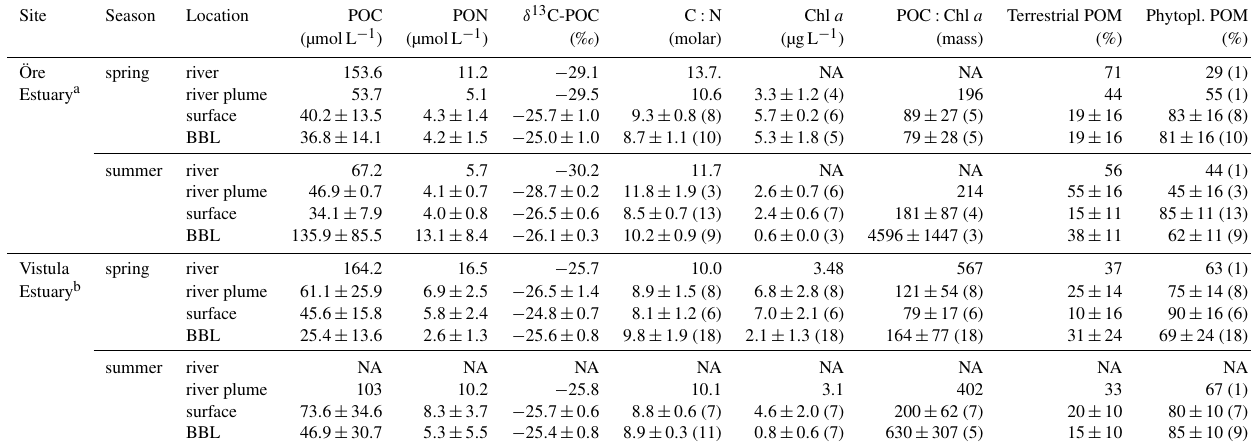
Table 2. Characteristics of particulate organic matter in the Öre and Vistula estuaries in spring and summer. The contribution of POM sources (terrestrial and phytoplankton) was estimated based on a two-component mixing model following Jilbert et al. (2018), using end members from Goñi et al. (2003). Values are average and standard deviation of each water layer. The number of replicates is shown in parentheses; NA – not available.